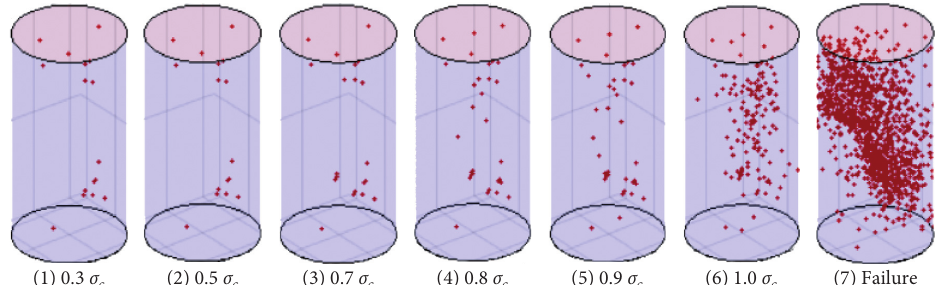
Figure 20: Spatial distribution of AE events at different stress levels for dry phyllite ( σ